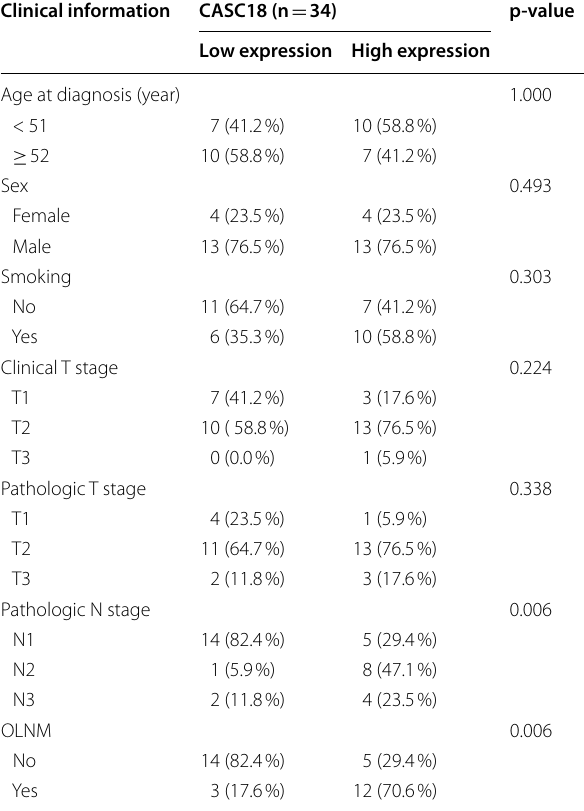
Table 1 Relationship between CASC18 expression